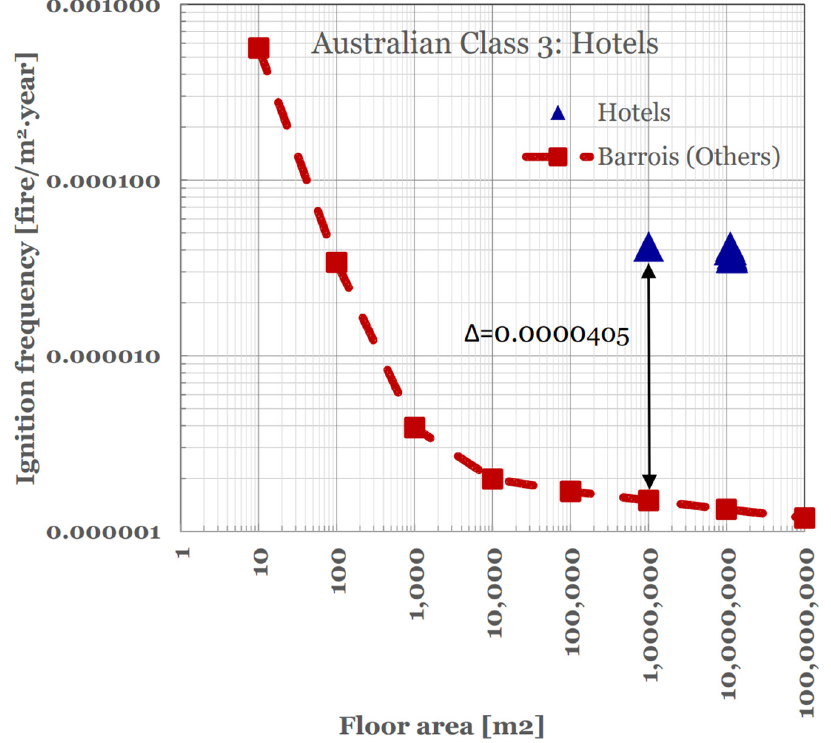
Figure 5. The ignition frequency curve for Class 3 (Hotels) in Australia from 2012 to 2019 was derived using the generalized Barrois model and the ignition frequency observations (blue triangles).